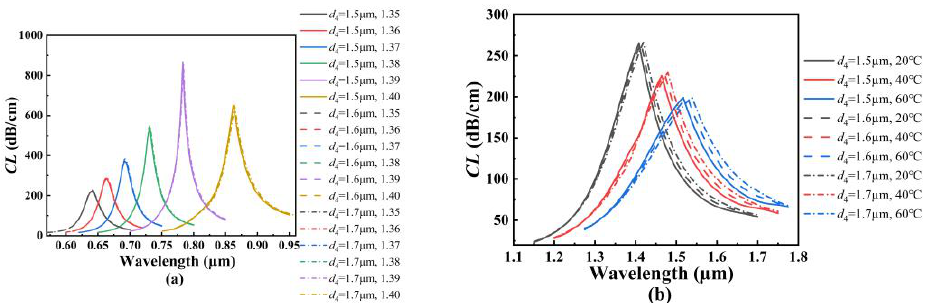
Figure 7. ( a ) The CL spectra of the core mode A when d 4 is set as 1.5, 1.6, and 1.7 μm, and when the analyte RI increases from 1.35 to 1.40, respectively. ( b ) The CL spectra of the core mode B when d 4 is set as 1.5, 1.6, and 1.7 μm, and when the temperature is chosen as 20, 40, and 60 °C, respectively.